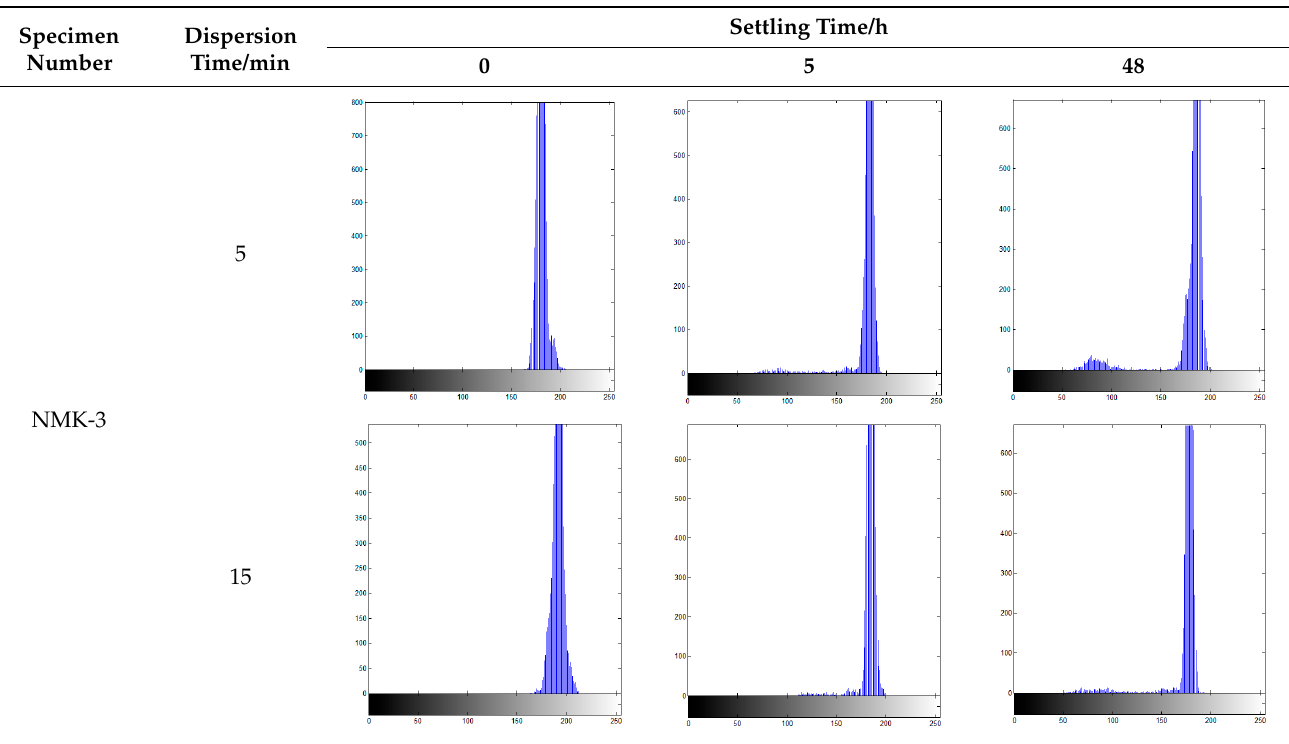
settlement time of the nanoclay suspension gray histogram is shown in Figure 6. Figure